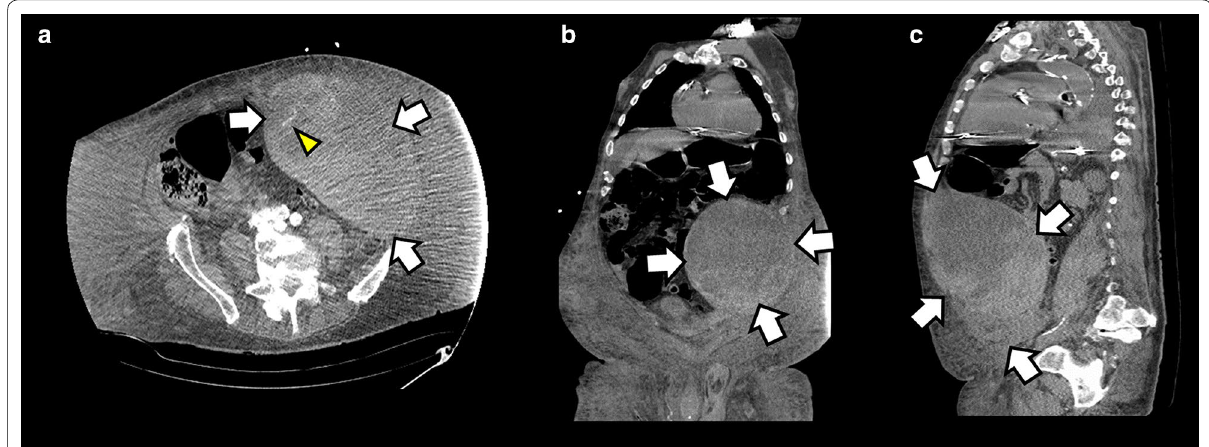
Fig. 2 Abdominopelvic computed tomography with intravenous contrast showing a large left RSH (arrows) extending to the pelvis. Signs of active contrast extravasation are shown in a (arrowhead), indicating active bleeding; a axial plane; b coronal plane; c sagittal